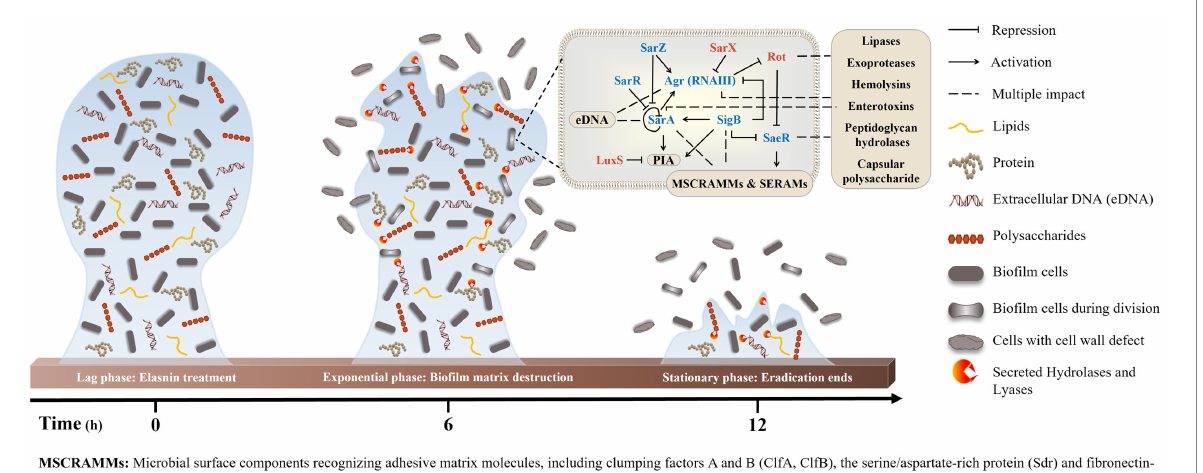
FIGURE 6 Proposed model of MRSA-biofilm eradication by elasnin. The peak of eradication occurred in the exponential phase, when a large amount of biofilm cells was undergoing cell division. Elasnin inhibited the expression of virulence regulons that controls virulence factors, such as adhesive proteins, cell-wall hydrolases and EPS, thereby interfering with cell division and generating cell-wall-defective cells. Moreover, the increased production of hydrolases and lyases degraded the old EPSs and subsequently released the biofilm cells from the